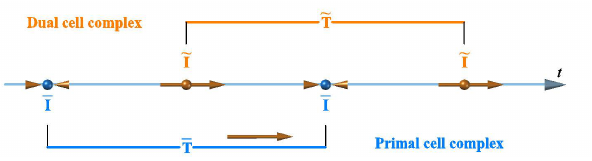
Figure 61: Time elements and their